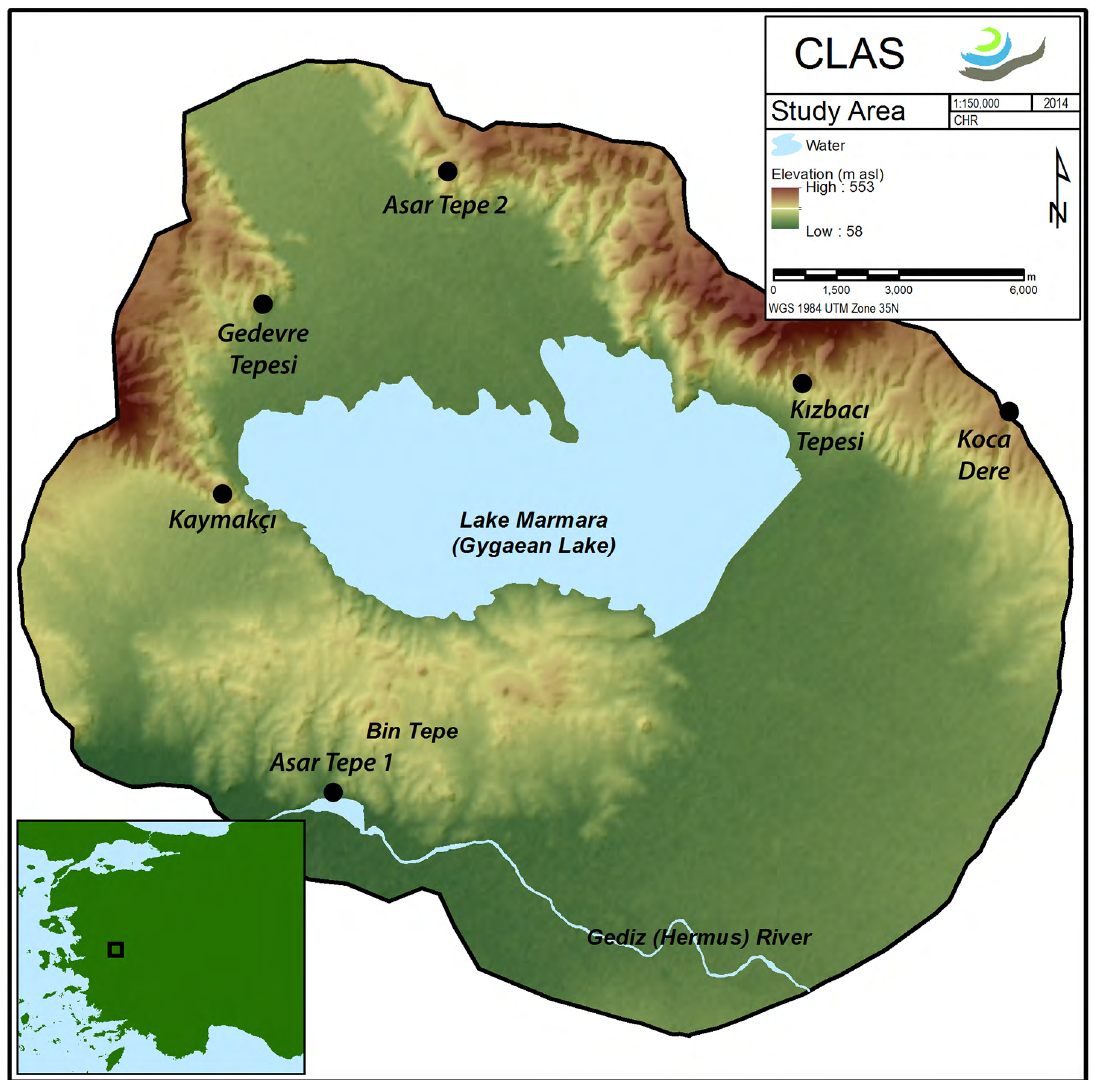
Figure 1: Map of the Central Lydia Archaeological Survey study area in central western Turkey, showing general toponyms and sites mentioned in the